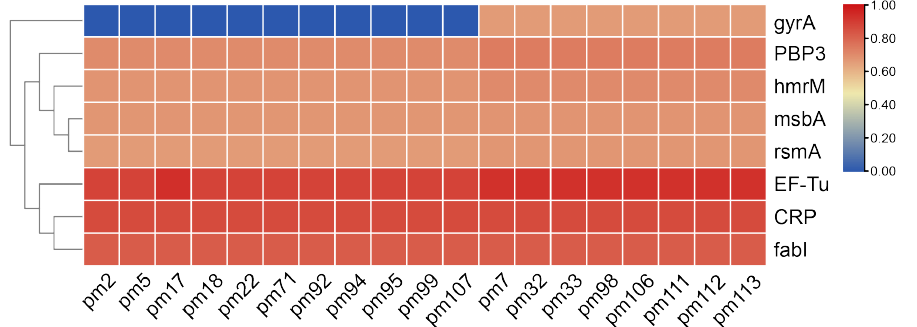
Figure 2. The heatmap of the genes associated with antibiotic resistance in P. multocida . The scale was determined by the identification of the matching